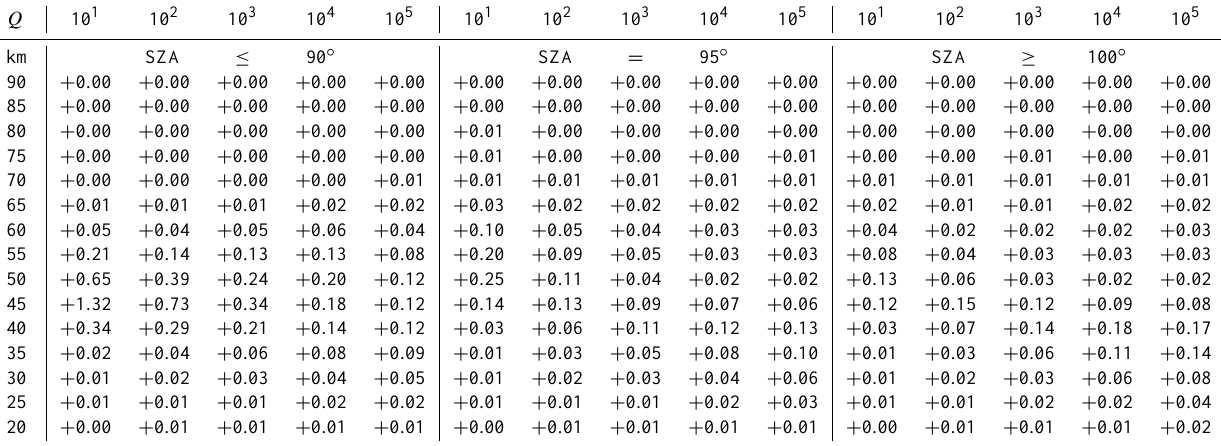
/Q for October NH. 3